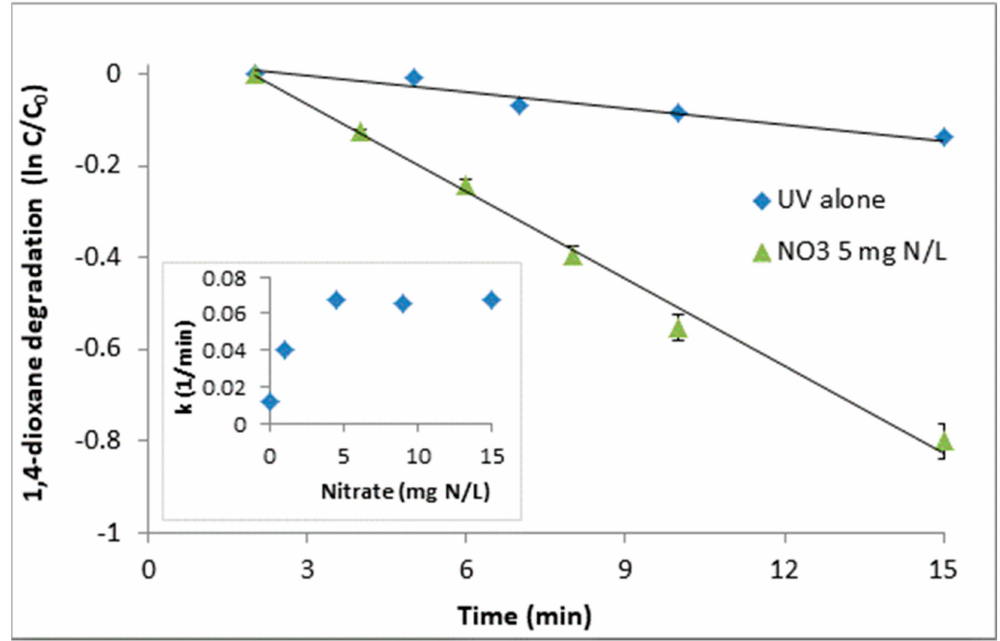
Figure 2. The degradation of 1,4-dioxane by UV alone and by UV/NO 3 (5 mg N/L). The inset presents the first-order rate constants vs. initial nitrate concentration. Experiments conducted in buffered deionized water (DI) at pH